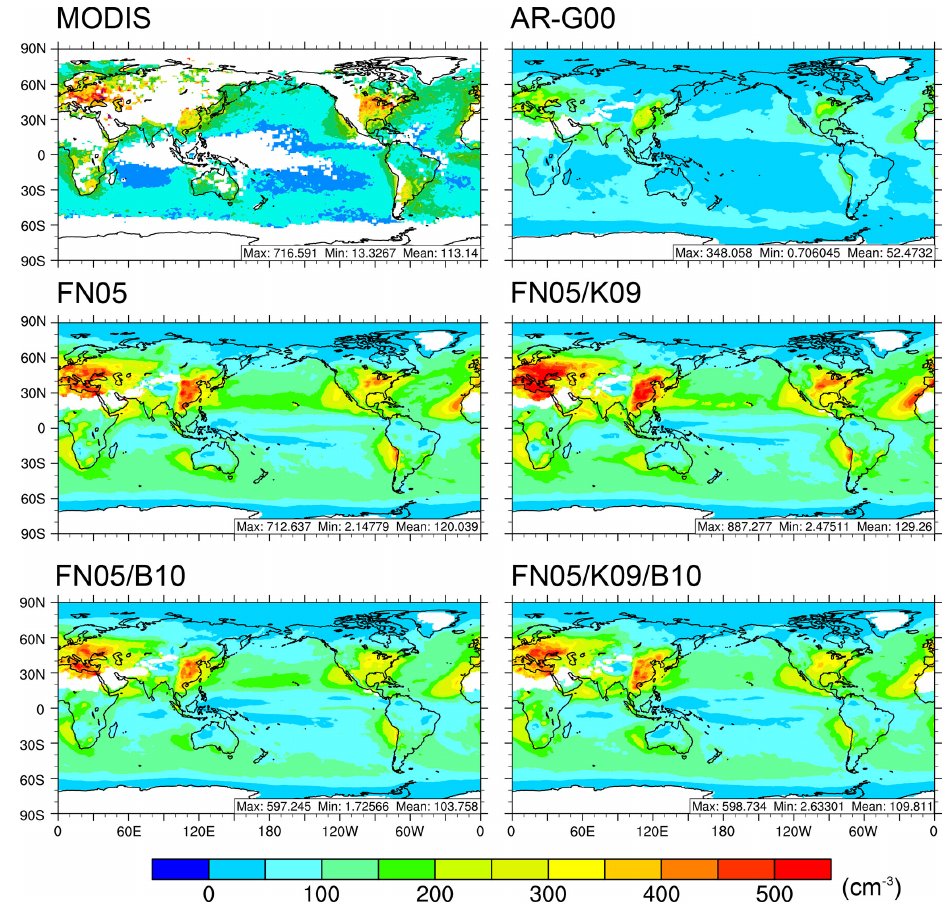
Figure 2. Annual average low-level CDNC from MODIS (Bennartz, 2007) and CESM/CAM5 (averaged between 960 to 850mb)